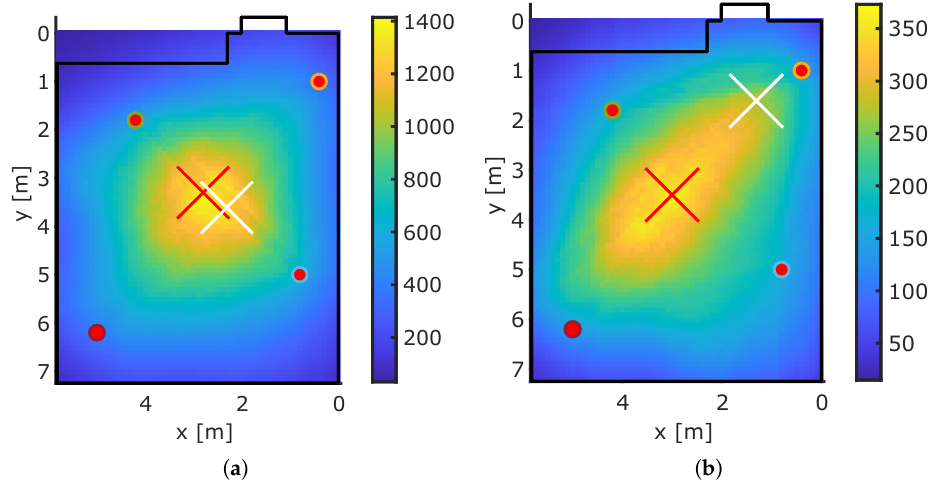
Figure 14. Exemplary MA-RTI results. ( a ) Exemplary Pos. 3. ( b ) Exemplary Pos.